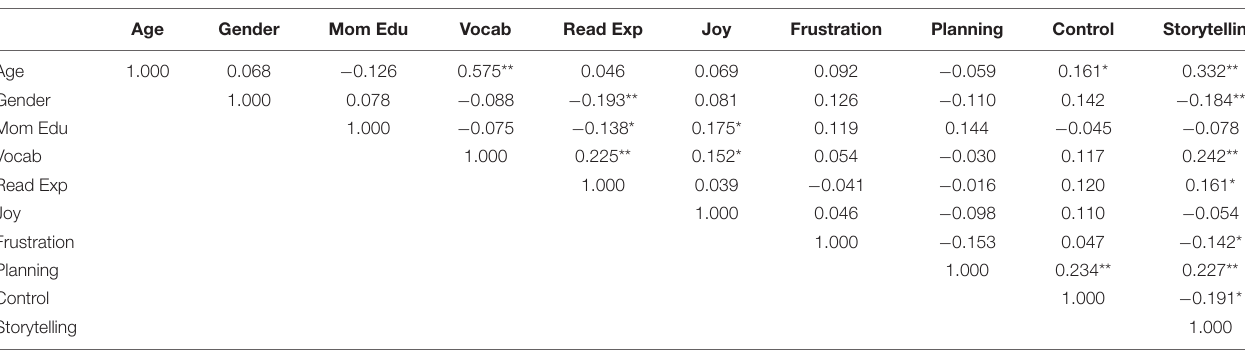
TABLE 2 | Covariates, IV, mediator and dependent